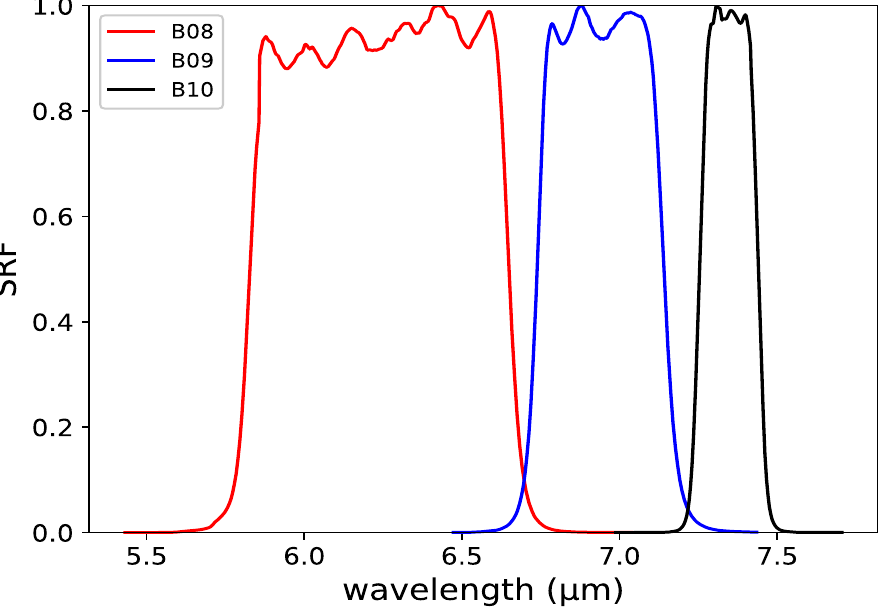
Figure 1. SRFs of the water vapor absorption IR bands for AHI.